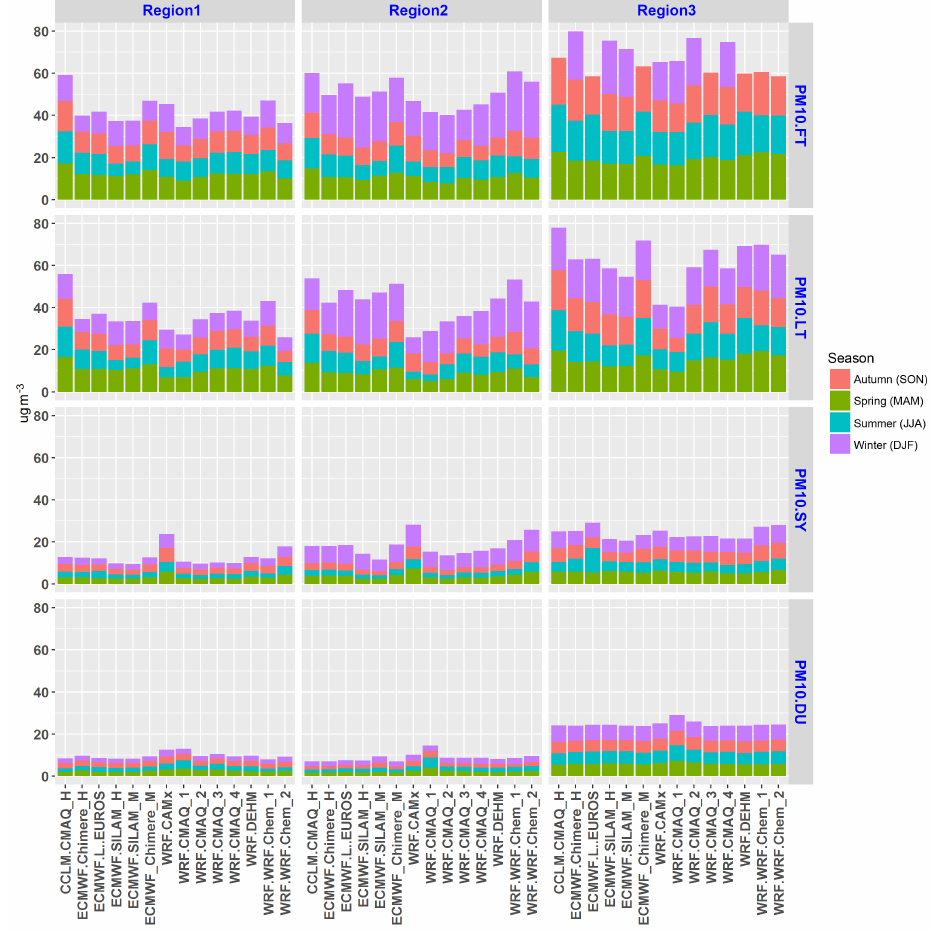
Figure 24. As in Fig. 9 but for PM 10 in Europe (error units in µgm − 3 ) .